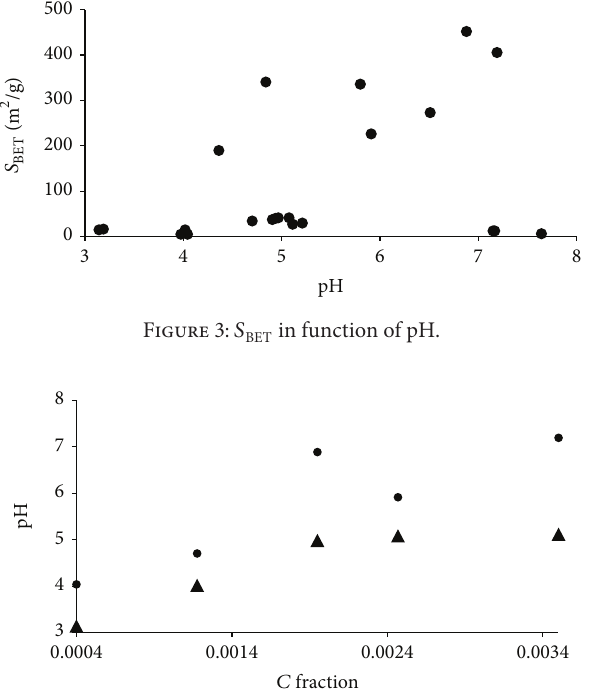
Figure 4: Mixture pH before cured in function of 𝐶 mass fraction: e 𝐿 mass fraction from 0.032 to 0.069; 󳵳𝐿 mass fraction from 0.087 to 0.140.